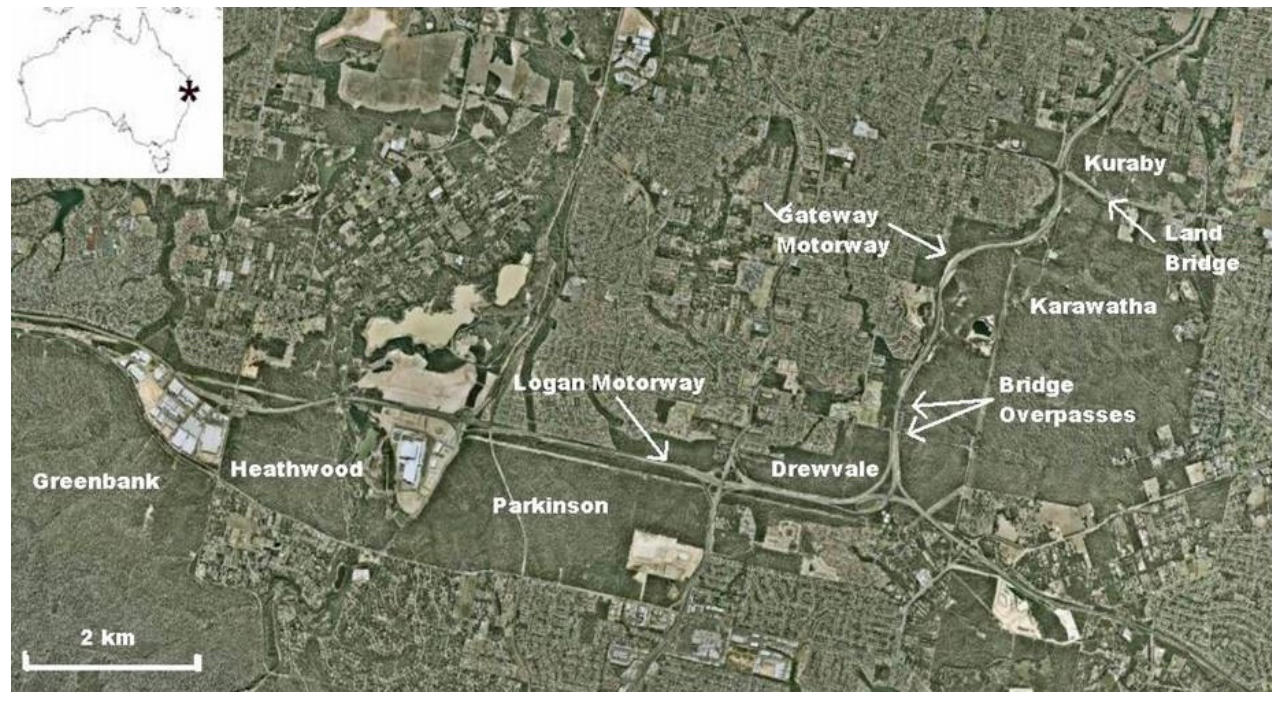
Fig. 1. Aerial photograph of the study area landscape showing six forest remnants and the location of the Compton Road land bridge. Source: Google